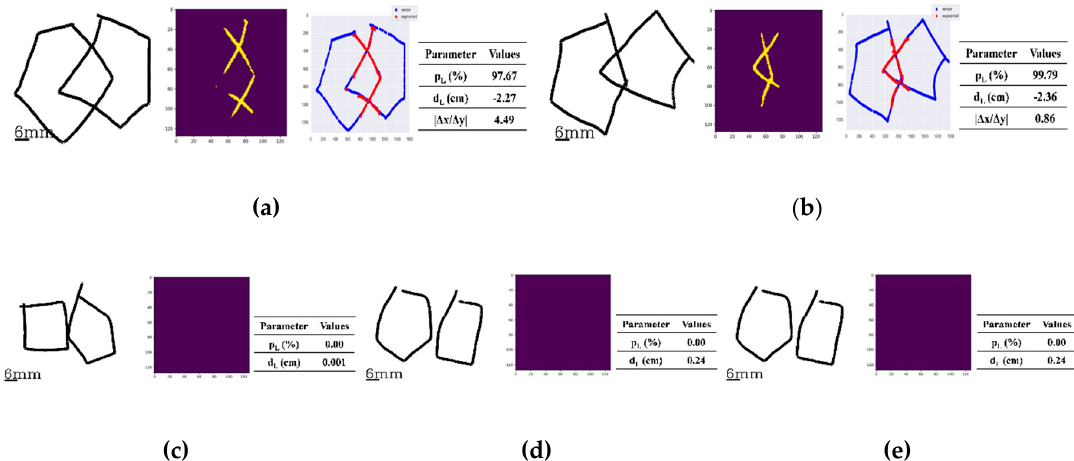
Figure 5. Five examples of the original drawing data along with the segmented images generated and analyzed by the pre-trained model, DeepLock (left and/or middle) and the corresponding parameter values (right). Below, the values in parentheses are the set comparator values for that parameter: ( a ) The case of the two interlocking figures giving a shape of a rhombus, where the percentage p L , the distance d L and the absolute value (cid:12) ∆ x / ∆ y (cid:12) of the ratio were evaluated to be 97.67% ( > 0.75%), -